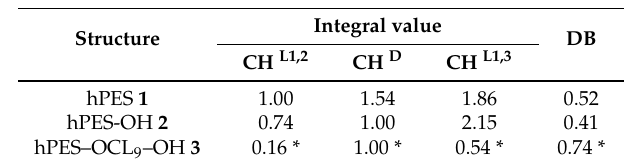
Table A2. Interpretation of inverse-gated (IG) 13 C NMR spectra of hyperbranched polyesters in DMSO-d 6 . Integral values of –CH– signals of relevant glycerol units for evaluating the degree of branching (DB).